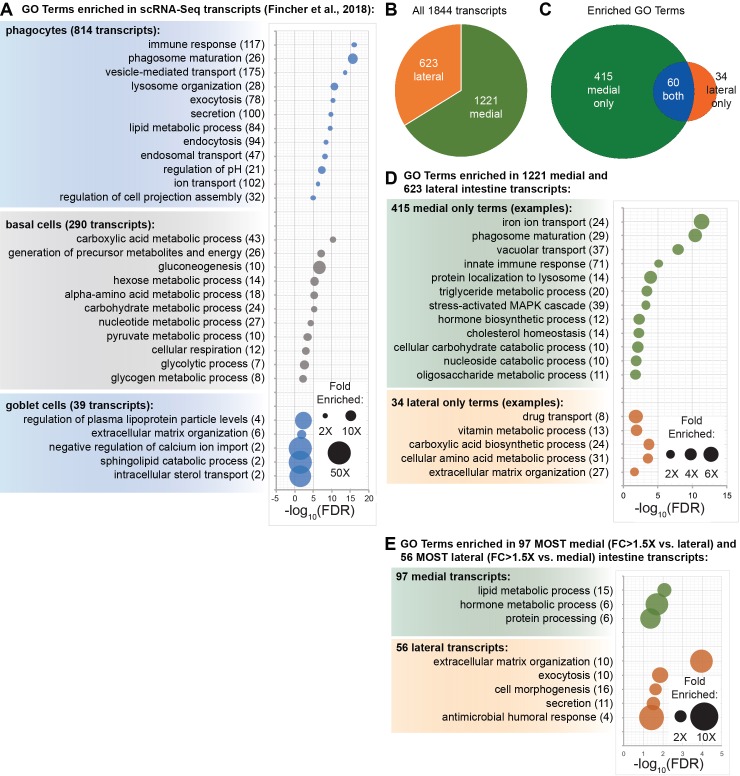
Enriched biological process GO terms for transcripts enriched in intestinal cell types and regions.(A) GO term enrichment for phagocyte-, goblet-, and basal-cell-enriched transcripts identified in Fincher et al. (2018). (B) Pie chart showing the ratio of transcripts with higher fold changes in laser-captured medial and lateral intestinal tissue. (C) Venn diagram showing the number of Biological Process GO terms enriched for medial, lateral, or both groups of transcripts. (D) Examples of GO terms over-represented only in medial and lateral transcripts. (E) Examples of GO term enrichment for only the most medially and laterally enriched transcripts. Detailed numerical data are available in Figure 6—source data 1.